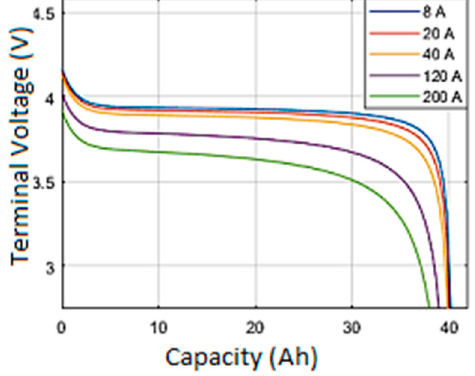
Figure 5. Discharge characteristics of proposed cell model.